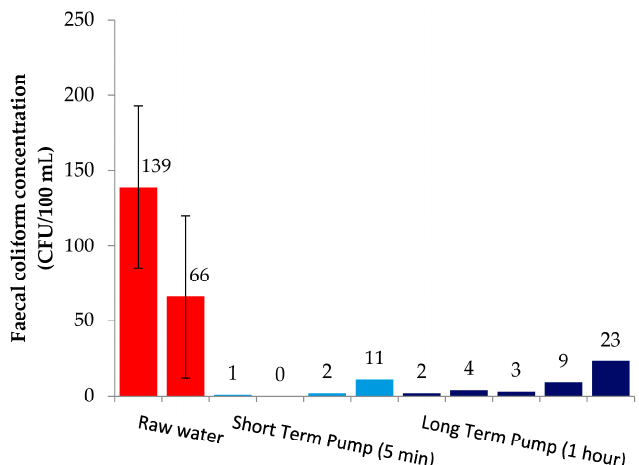
Figure 6. Faecal coliform concentrations in raw water and in treated water at short- and long-term pumping. The raw water results depict the average of seven samples, while the remaining bars illustrate individual samples.